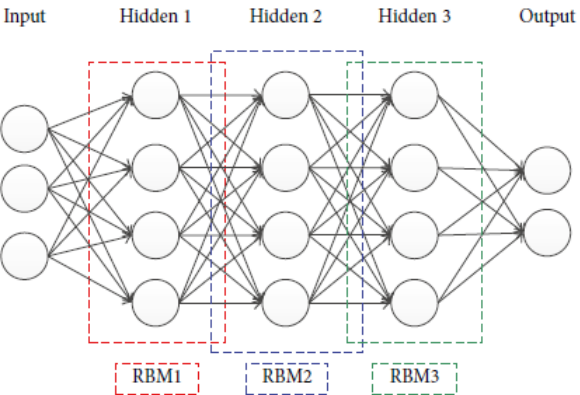
Figure 1. Illustration of a typical DBN structure.